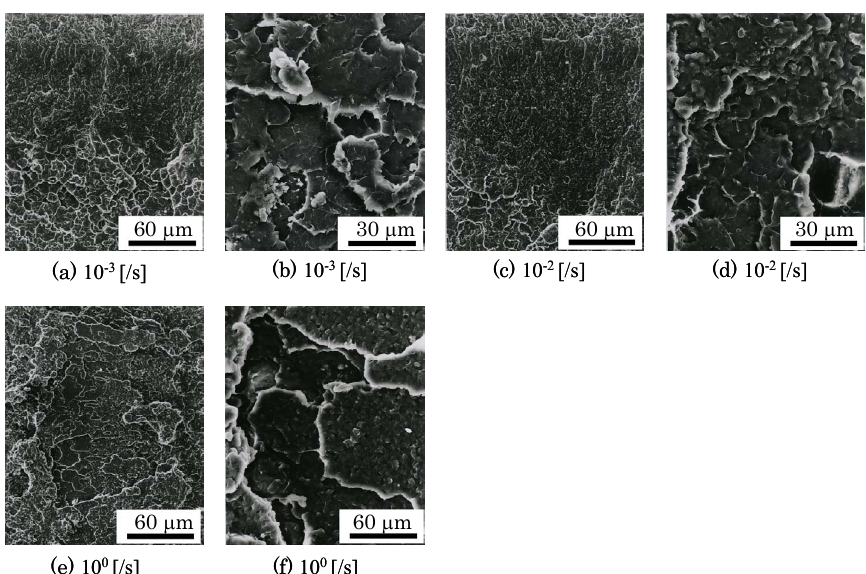
Figure 6 Fracture surface of 130ºC-24h specimens observed by scanning electron microscopy.